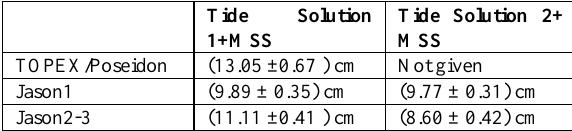
Table 7 . Average of MAE values at all test points over the Baltic Sea for the TOPEX/Poseidon, Jason 1, 2, 3 altimetry